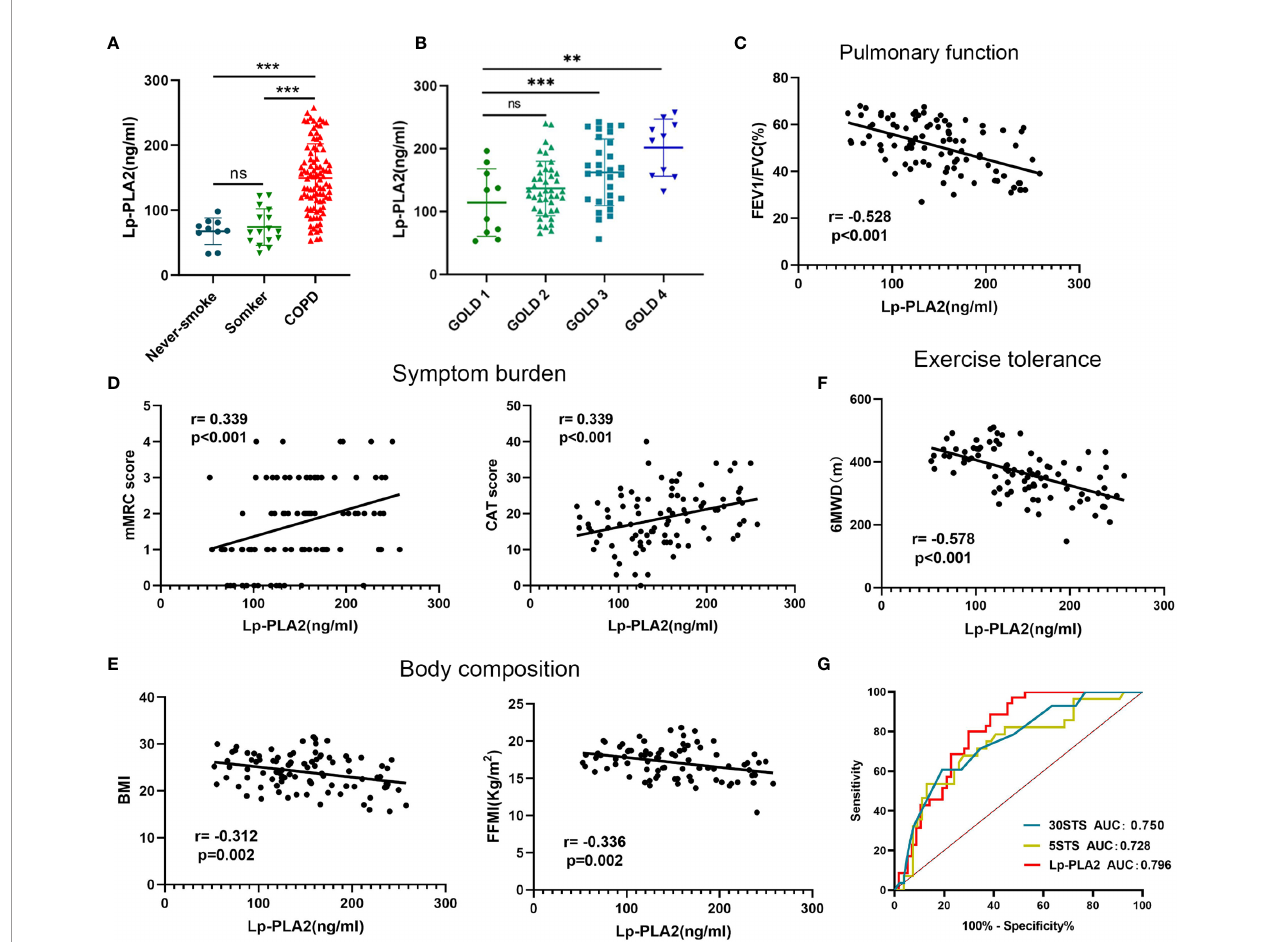
FIGURE 6 | The clinical value of Lp-PLA2 level for COPD patients. (A) Lp-PLA2 level in serum tended to be higher in COPD patients than healthy smokers; (B) Lp- PLA2 level increase along with GOLD stage; (C) Lp-PLA2 level was negative correlate with FEV1/FVC (r=-0.528, p<0.001); (D) Lp-PLA2 level was positive correlate with mMRC score (r=0.339, p<0.001) (left) and CAT score (r=0.339, p<0.001) (right); (E) Lp-PLA2 level was negative correlate with BMI (r=-0.312, p=0.002) (left) and FFMI (r=-0.336, p=0.002) (right); (F) Lp-PLA2 level was negative correlate with 6MWD (r=-0.578, p=0.002); (G) ROC curve analysis of the Lp-PLA2 level, the 5STS score and the 30STS score for predicting 6MWD <350 m. ns, not statistically signi fi cant, **P < 0.01 and ***P <